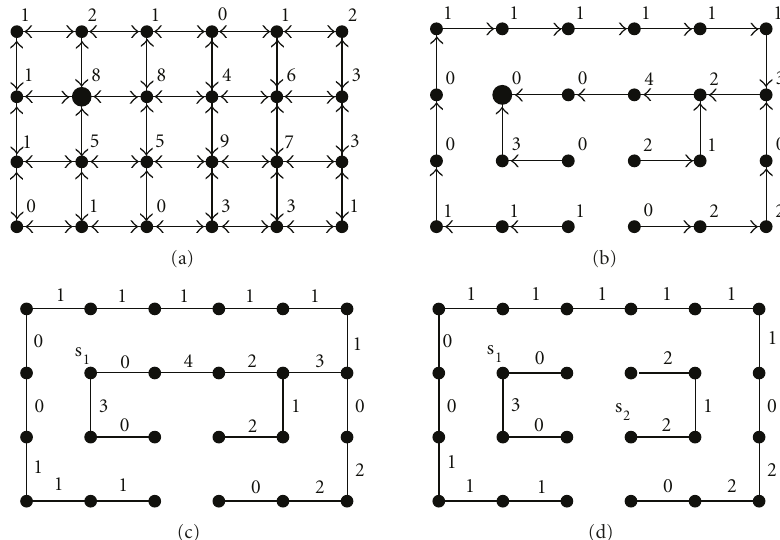
Figure 4: (a) An image graph with 4-adjacency, where the integers are the image values I ( p ) and the bigger dot is an arbitrary pixel. The object of interest is the brighter rectangle in the center. (b) A minimum-spanning tree computed from the arbitrary pixel, where the integers for each pixel q are the arc weights δ ( p , q ) = | I ( q ) − I ( p ) | , for p = P ( q ). (c) The minimum-spanning tree without arc orientation. A single seed s 1 can not extract the rectangle for any value of κ . (d) The rectangle can be obtained with two seeds and distinct values of κ , s 1 with κ 1 = 3 and s 2 with κ 2 =